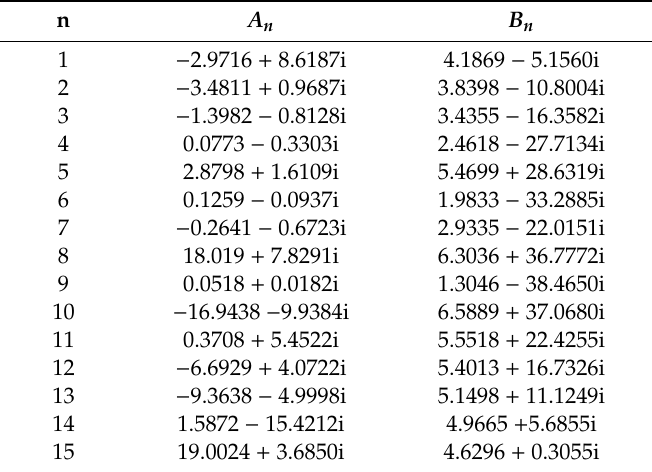
Table 1. Multi-Gaussian function superposition coe ffi cients